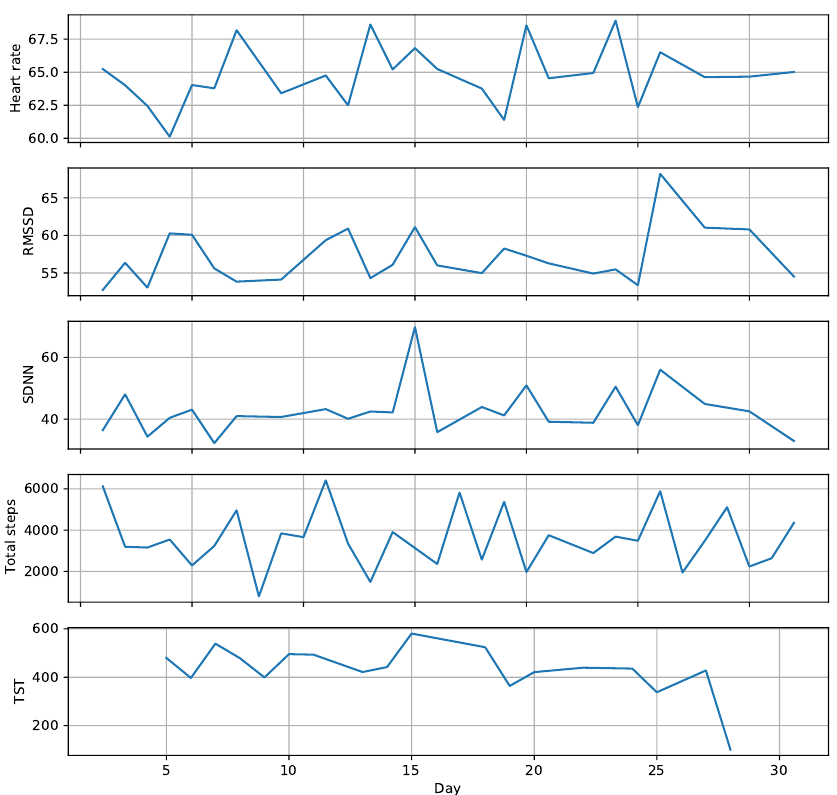
Figure 3. A one month sample of collected data from one participant during pregnancy.